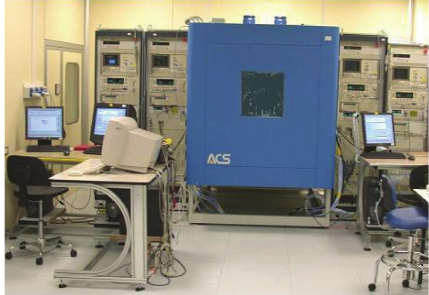
Figure 12: Tile production line is shown with 2 ATE (automatic test equipment) working in parallel on two tiles to perform test in temperature of all the 128 RF chains.